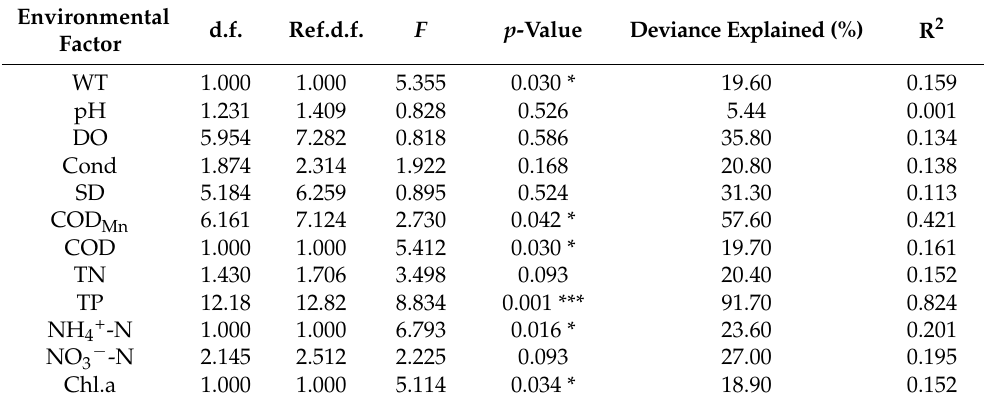
Table 5. GAM model analysis of TOC concentration and environmental factors in Han